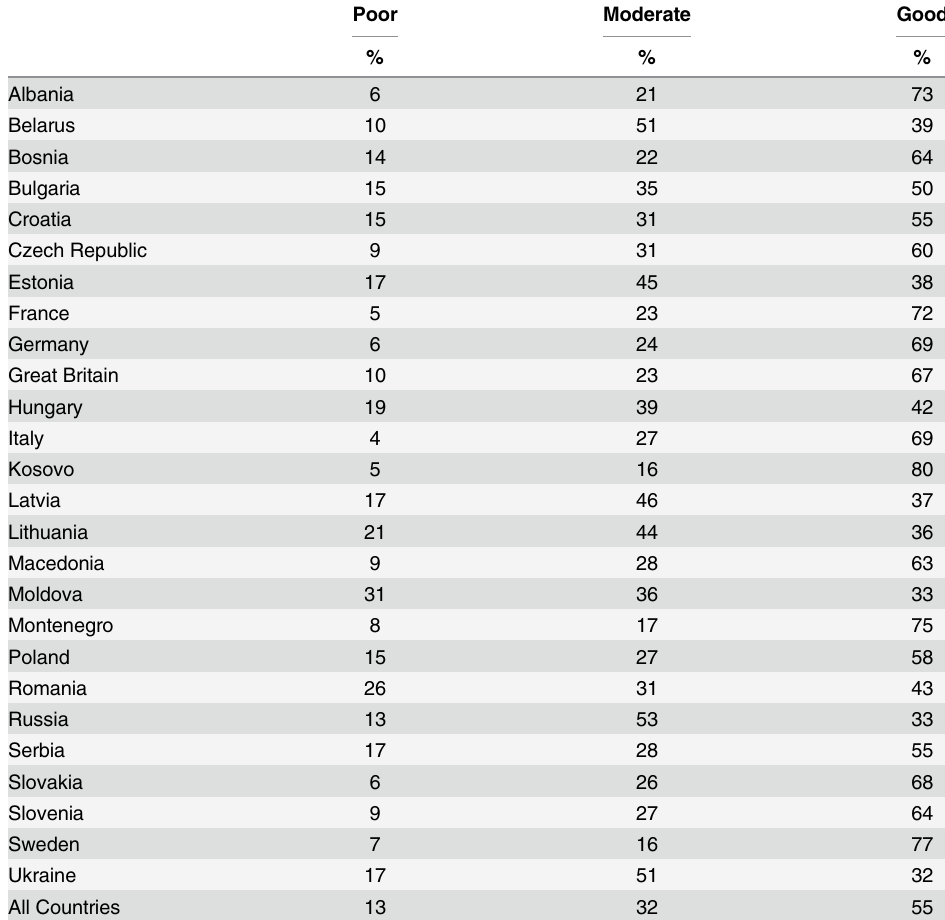
Table 2. Self Rated Health by